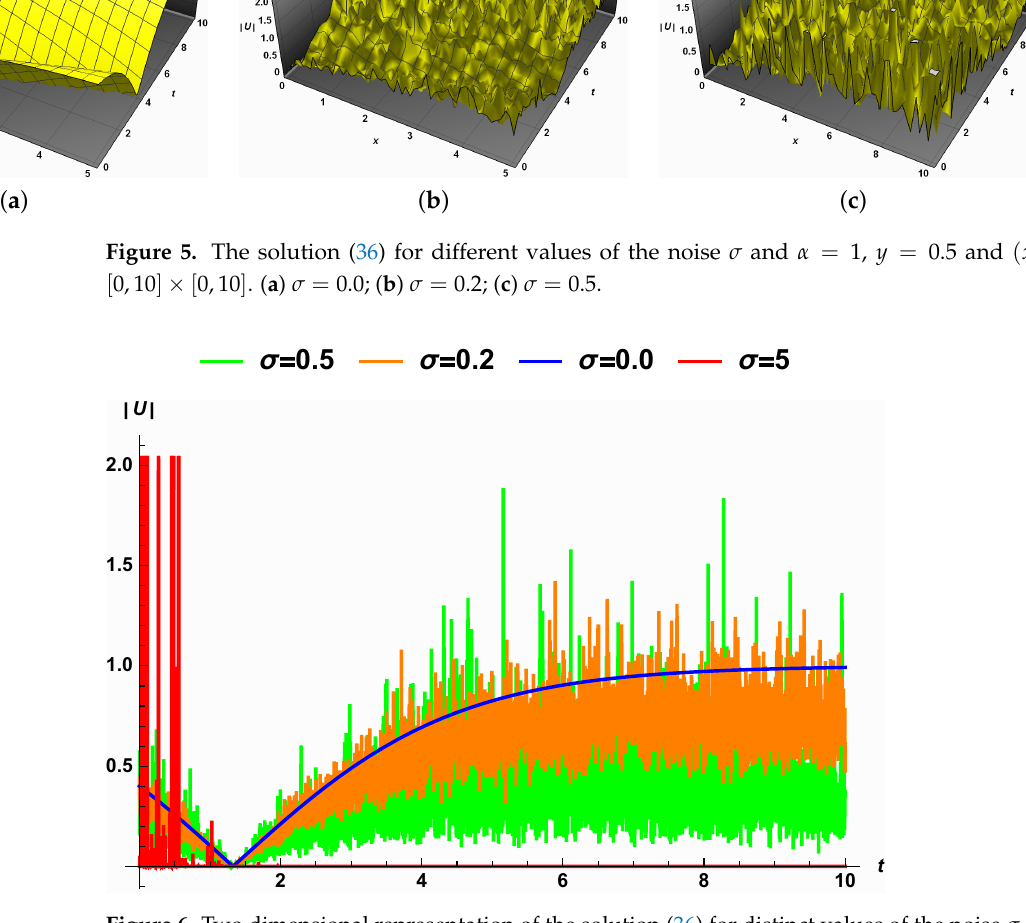
Figure 6. Two dimensional representation of the solution (36) for distinct values of the noise σ , α = 1, x = 1, y = 0.5, and t ∈ [ 0,10 ]